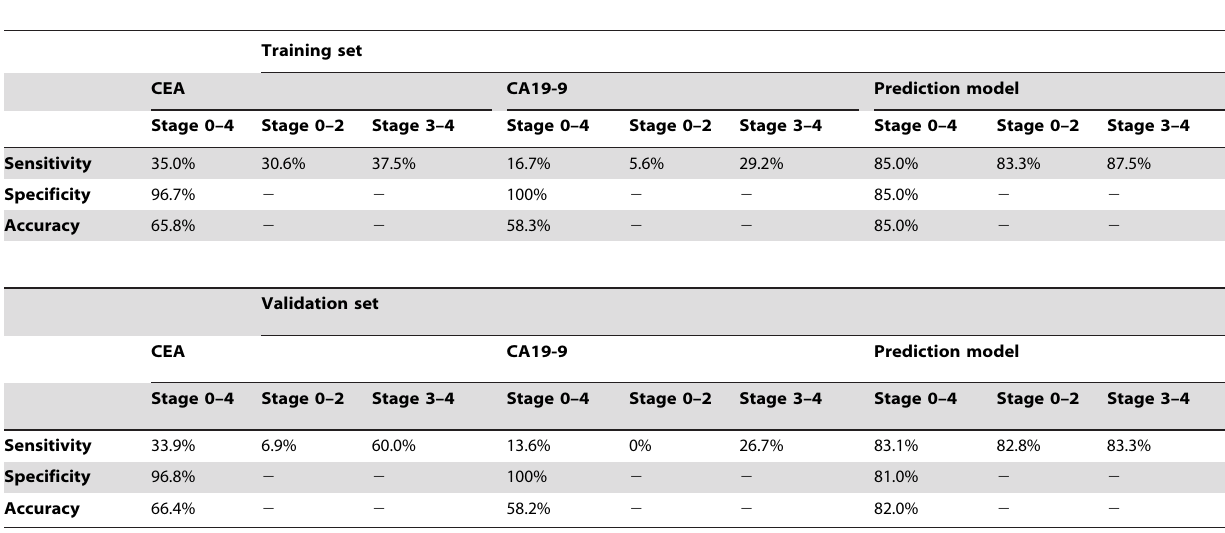
Table 5. The sensitivity and specificity of tumor biomarkers and the prediction model.